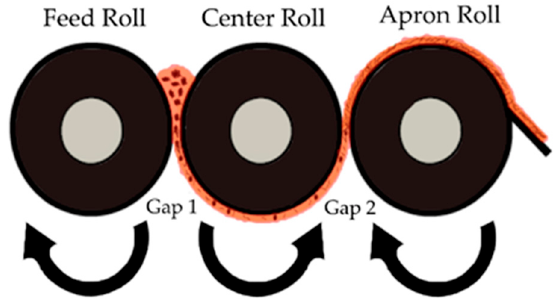
Figure 1. Three-roll mill schematic: suspension is fed between the first two rolls, passes through gap 1 and gap 2 and is finally collected completing a "pass" cycle.